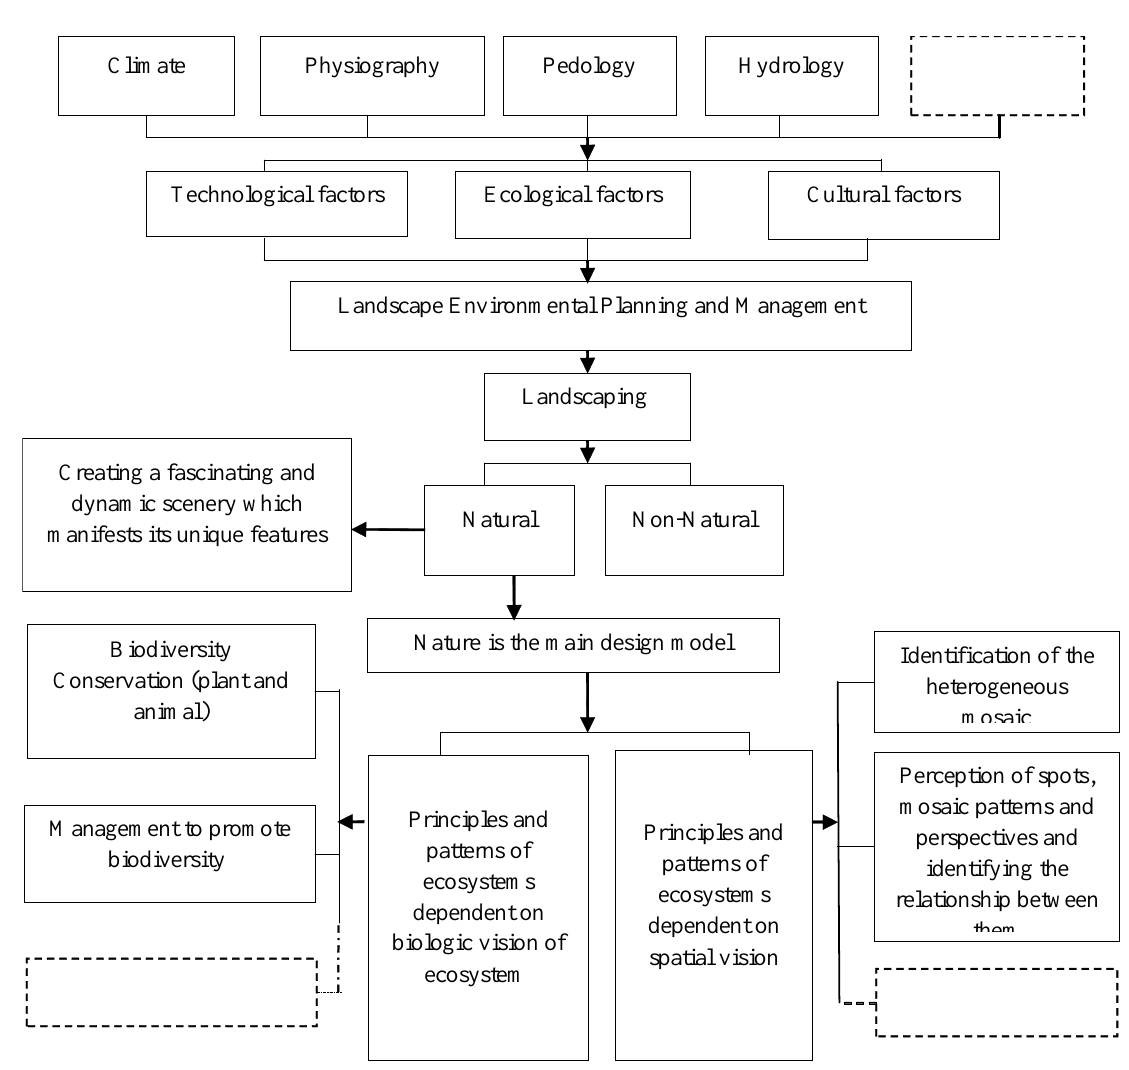
Fig. 4: Environmental Planning and Management